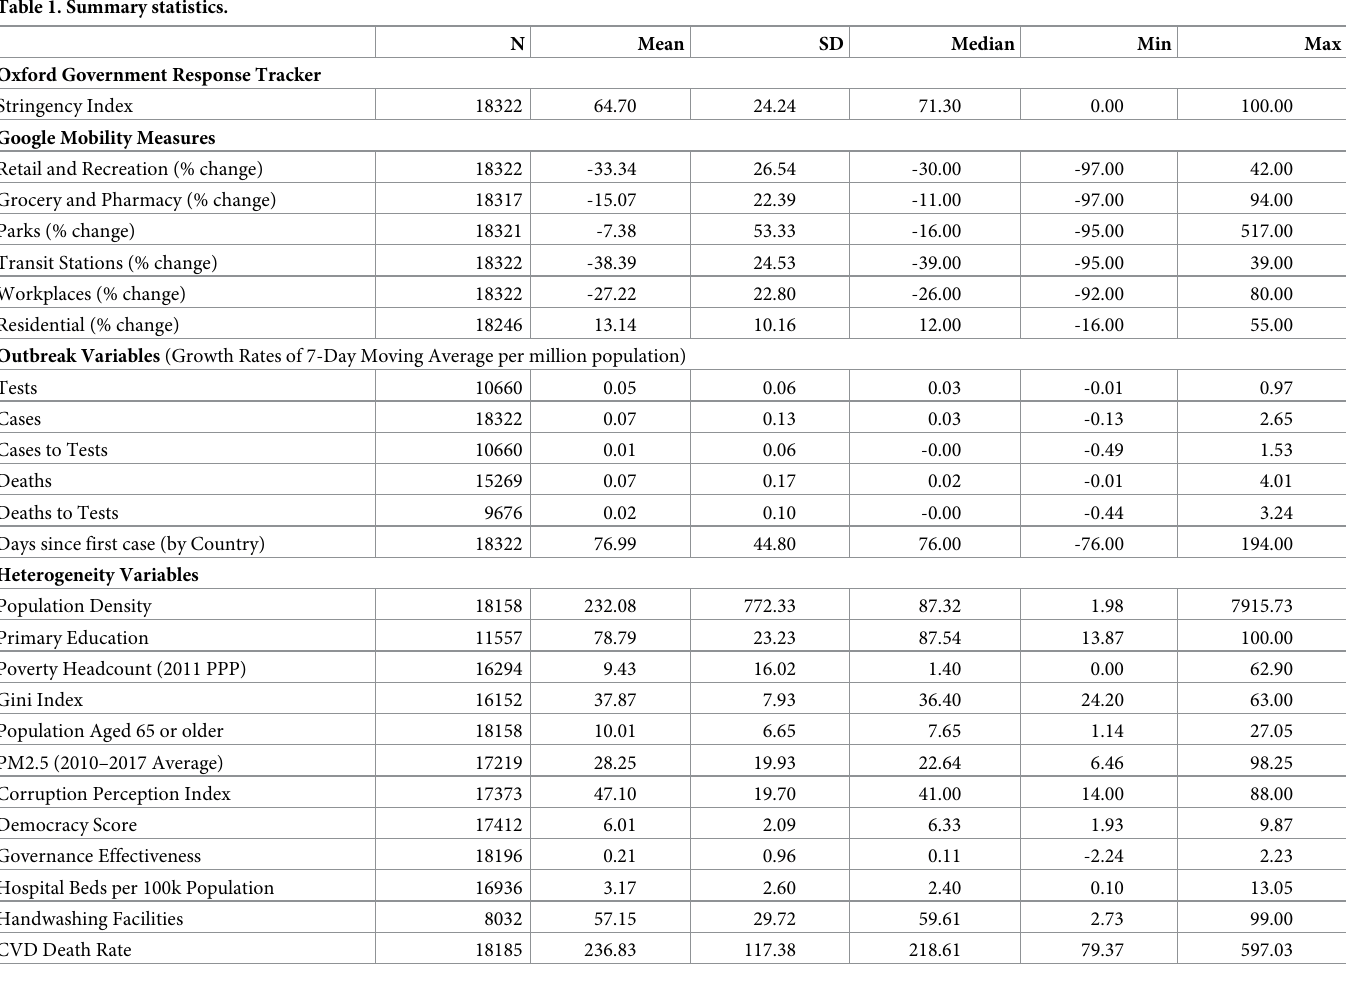
Table 1. Summary